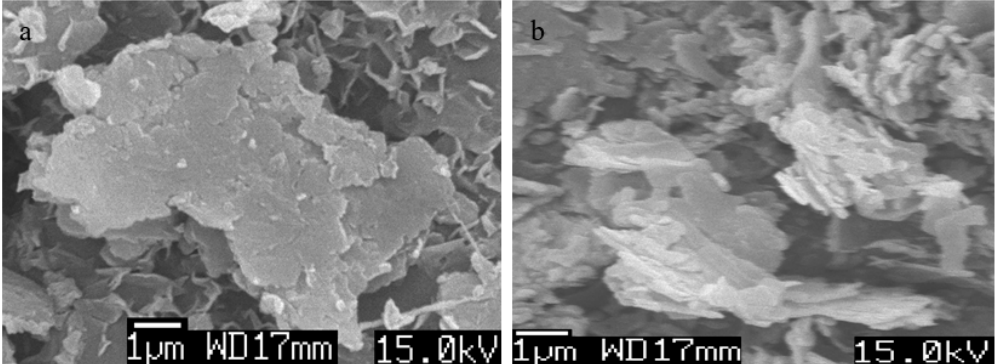
Figure 8. SEM images of ( a ) Ni-Ti-5 LDHs and ( b ) Ni-Ti-3 LDHs